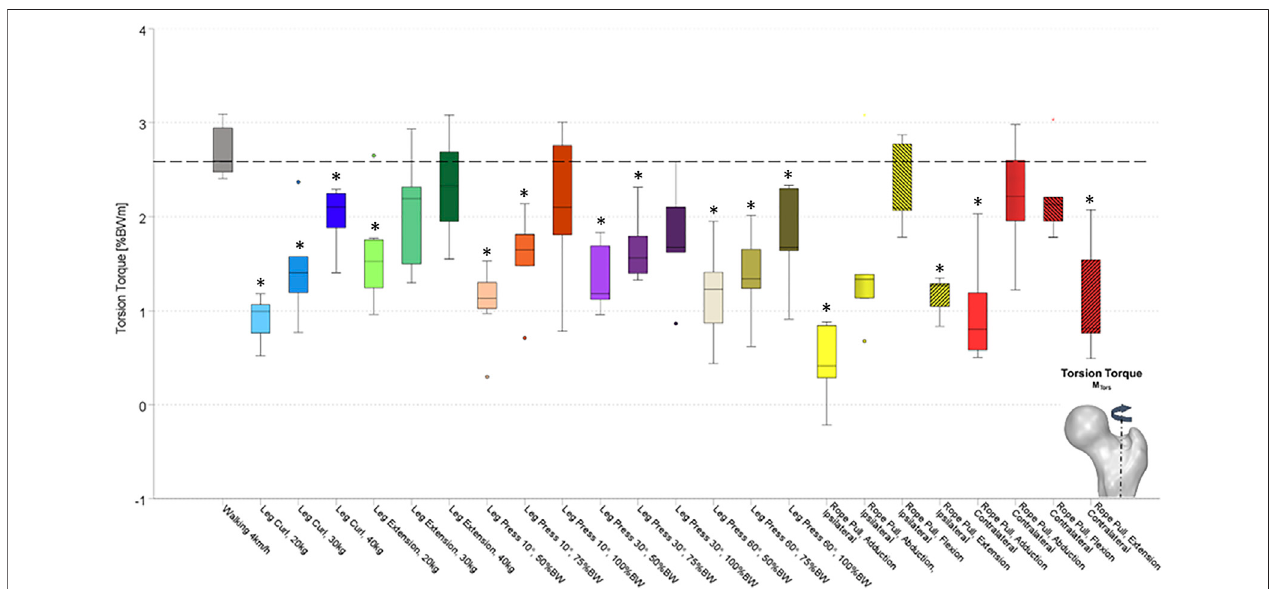
FIGURE 3| Resultantbending moments acting at the femoral neck (M bend ), while performing several activities on different training devices. Values were compared towalkingasreferenceactivityatasigni fi cancelevelof p ≤ 0.05.Signi fi cantdifferencestowalkingaremarkedwithanasterisk(*).Exerciseswereperformedatthelegcurl and the leg extension machine with different load conditions (20, 30, and 40 kg), at the leg press machine with different load conditions (50, 75, and 100%BW) and a different inclination of the backrest (10 ° , 30 ° , and 60 ° ), and the rope pull machine with a load of 10 kg and hip adduction, abduction, fl exion, and extension on ipsilateral and contralateral leg. Ipsilateral and contralateral regarding the standing leg is either the implanted instrumented hip prothesis (ipsilateral) or the not operated side (contralateral). Rope pull exercises performed with ipsilateral side, standing on the contralateral leg referred to as ipsilateral. Rope pull exercises performed with contralateral side, standing on the ipsilateral leg referred to as